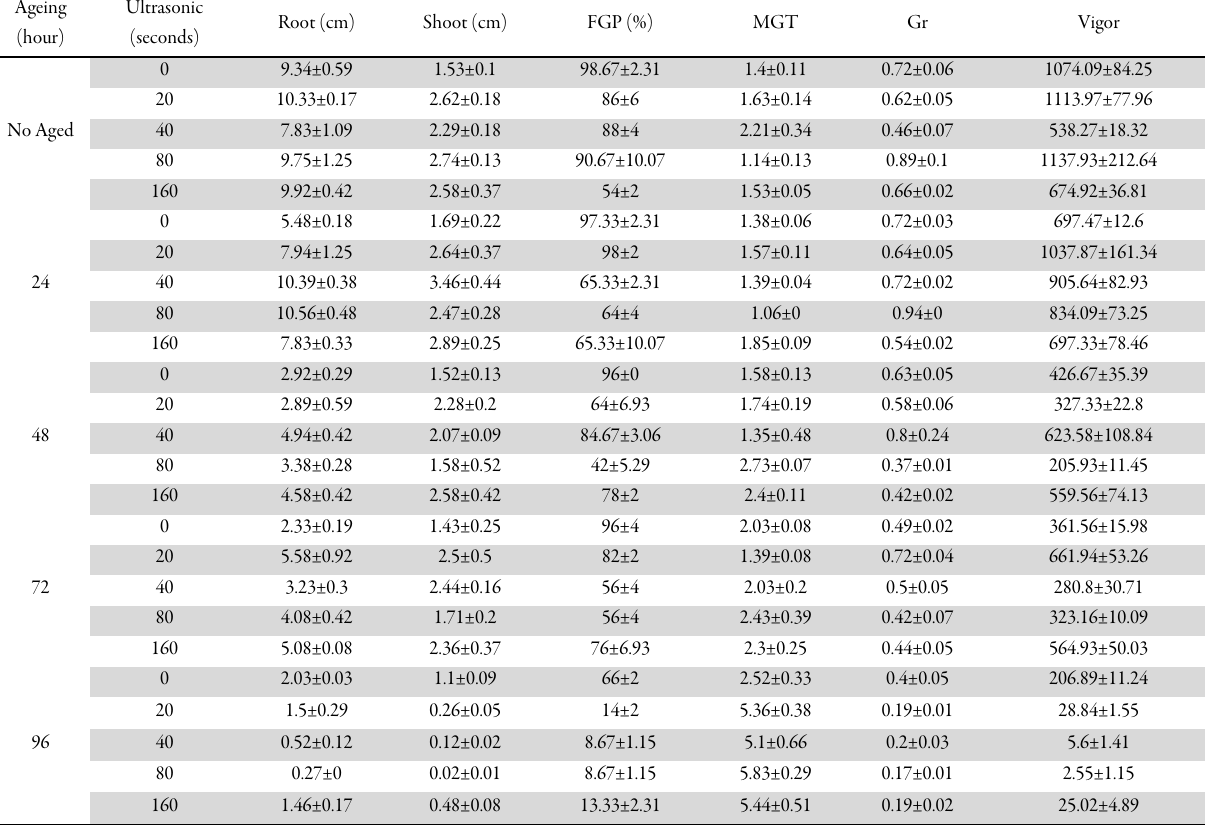
Table 1. Mean comparison of interaction effects (Aging durations * Ultrasonic Assisted Sp) Ageing